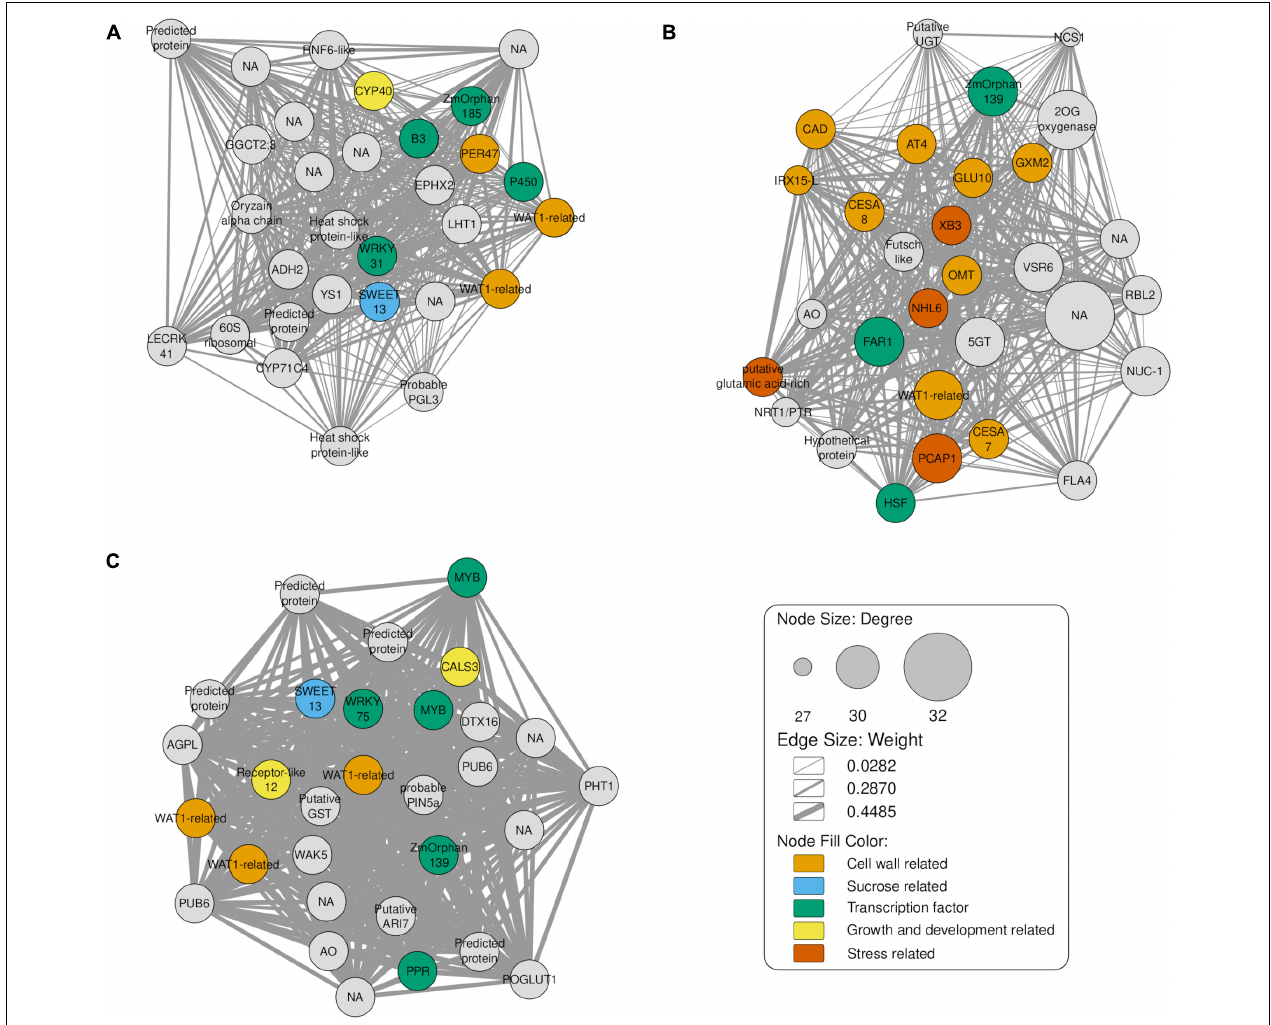
FIGURE 6 | Gene co-expression network of the top 30 hub genes, as indicated by the maximal clique centrality. The node sizes represent the degree of correlation with other genes. Light orange, light blue, green, yellow, orange nodes represent cell wall related, sucrose related, transcription factor, growth and development related and stress related genes, respectively. The edges represent interactions between genes and their width indicates the corresponding weight. (A) Comparison of T2 (8-months) against T1 (6-month-old plants). (B) Comparison of T3 (10-months) against T1. (C) Comparison T4 (12-months) vs.